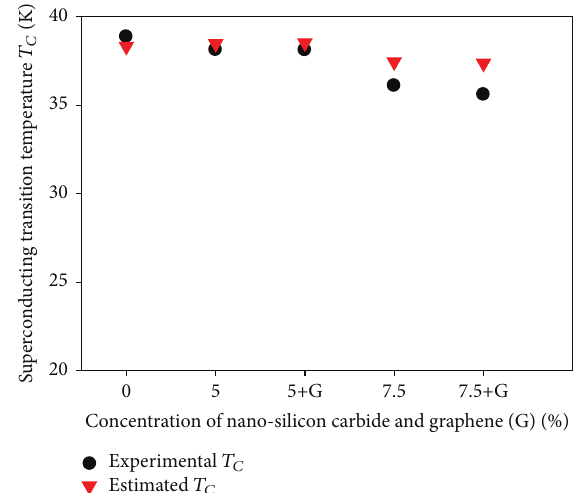
Figure 3: Effect of nano-silicon carbide and graphene on 𝑇 𝐶 of MgB 2 superconductor using the developed model.